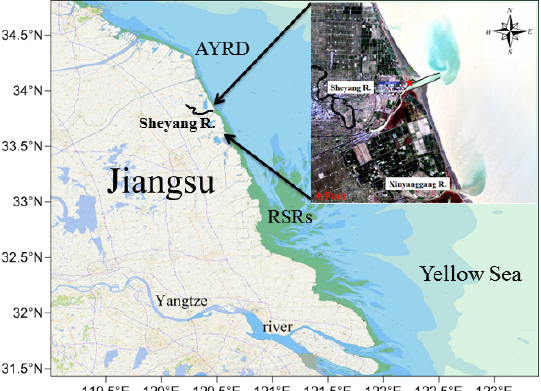
Figure 1. The Jiangsu muddy coast. The inserted satellite image shows the layout of the Sheyang port.